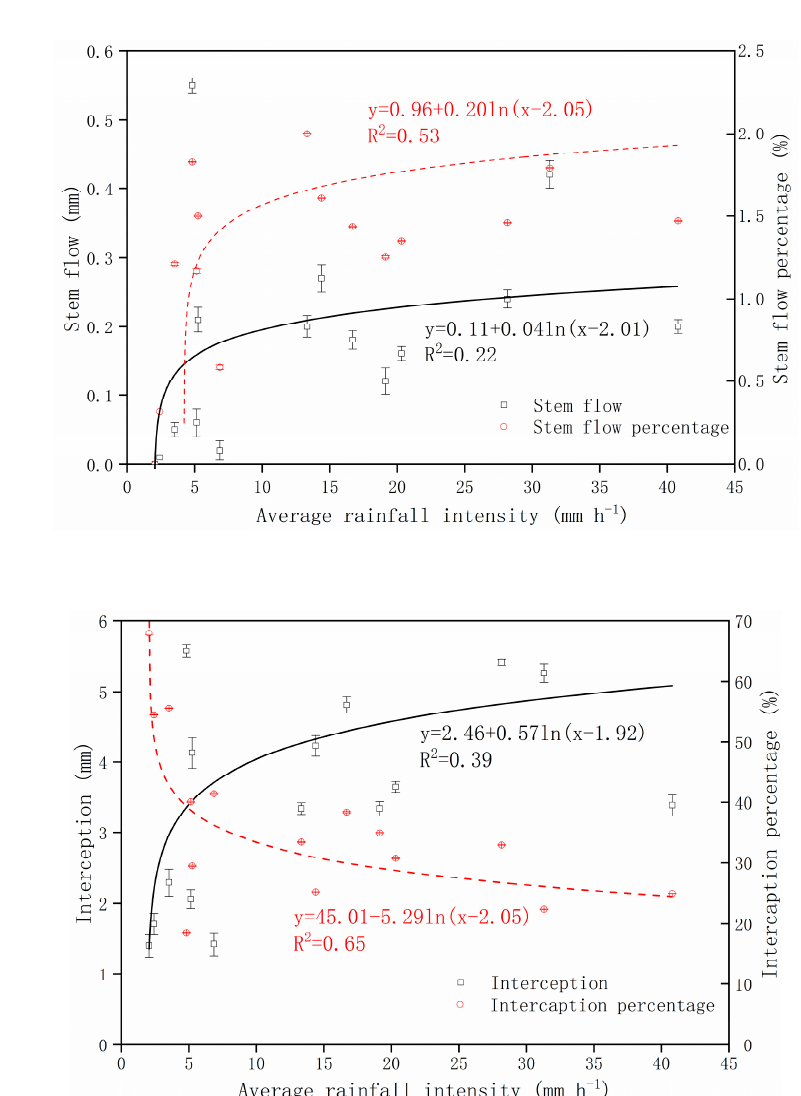
Figure 3. Rainfall redistribution as a function of rainfall intensity. ( a ) Distribution of throughfall and its percentage with rainfall intensity; ( b ) Distribution of stem flow and its percentage with rainfall intensity; ( c ) Distribution of interception and its percentage with rainfall intensity.